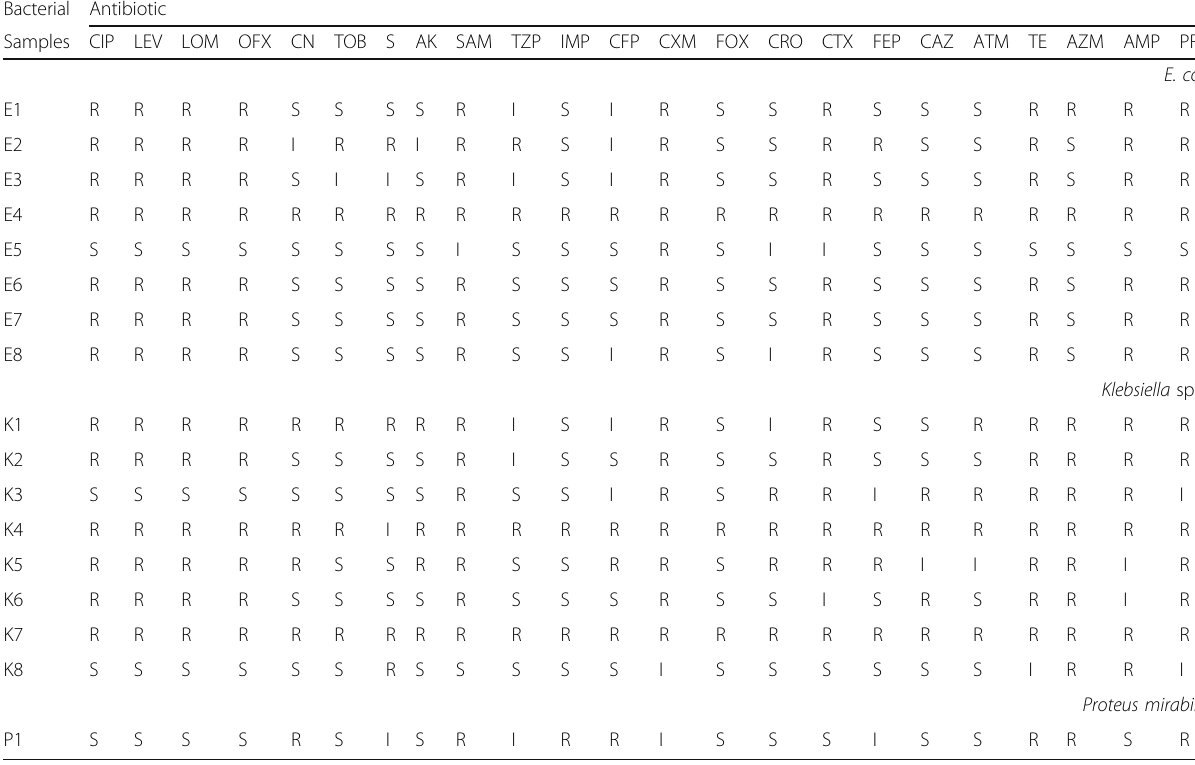
Table 3 Susceptibility test of the studied KLebsiell a spp.(K) ,E. coli and Proteus mirabilis (P) isolates against standard antibiotics Bacterial